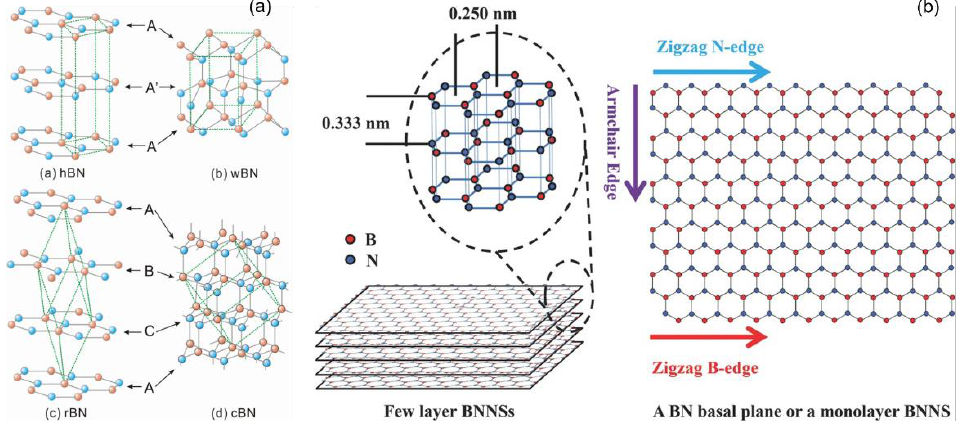
Figure 2. ( a ) Crystal structures of h-BN, w-BN, r-BN, and c-BN. Boron atoms are shown in red, while nitrogen atoms are shown in blue [28]. Reproduced with permission. 2007 IOP Publishing Ltd. ( b ) Structural basis for two-dimensional h-BN nanostructures, where B-N bonds have the length of 0.145 nm, the distance between two adjacent borazine rings is 0.250 nm, and the interlayer distance is 0.333 nm. The edge of the monolayer BN nanosheet can be either zigzag or armchair [13]. Reproduced with permission. Copyright 2017 WILEY-VCH Verlag GmbH & Co. kGaA (Weinheim, Germany).